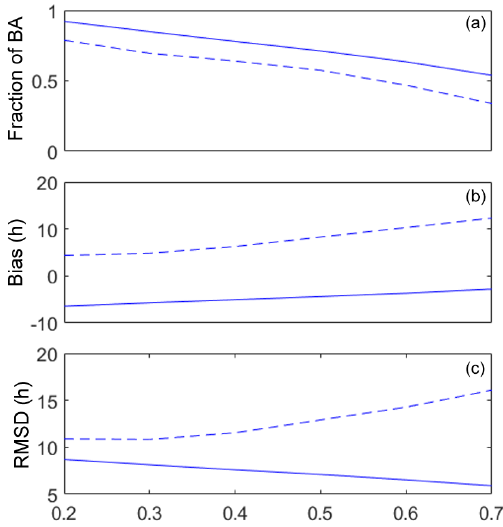
Figure 8. Fraction of the burned area inside the perimeter relative to the total area inside the perimeter of the fire scar (a) , bias (b) and root-mean-square difference (c) as a function of the probabil- ity threshold for c 1 = 0 . 045 and c 2 = 0 . 131. The dashed lines cor- respond to the baseline model and the solid lines to the modified